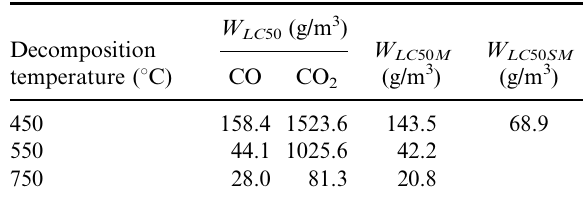
Table 11. Toxicometric indicators of modified